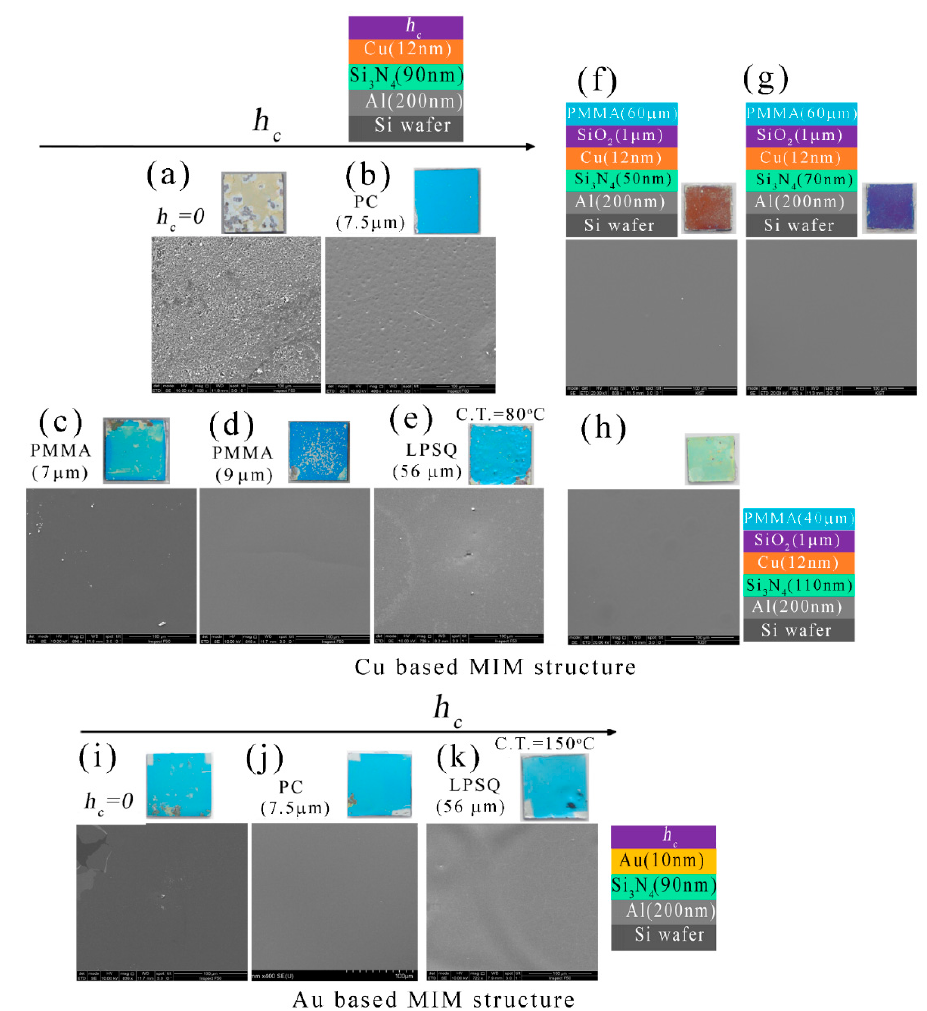
Figure 8. The scanning electron microscopy (SEM) images of the humidity test specimens: ( a – h ) Cu-based MIM structures; ( i – k ) Au-based MIM structures. The scale bar in all images is 100 µ m. The plan-view SEM images of the salt spray test specimens are shown in Figure The SEM images of the capped and uncapped Au (10 nm)/Si 3 N 4 (90 nm)/Al structure